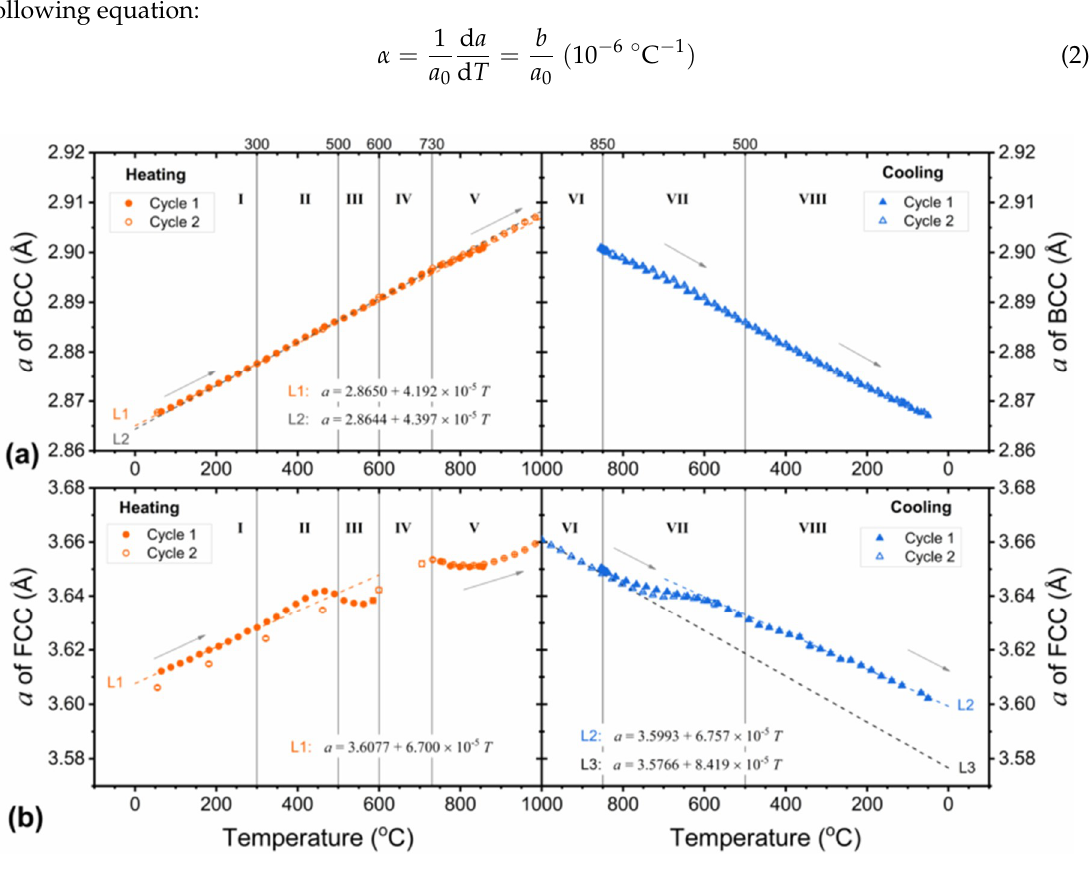
Figure 5. Evolution of lattice parameter as a function of temperature: ( a ) BCC and ( b ) FCC. The dash lines are the linear fittings by Equation (1) in different temperature regions: ( a ) L1 for 60~300 °C, L2 for 600~700 °C, and L3 for 900~1000 °C; ( b ) L1 for 60~300 °C, L2 for 300~60 °C, and L3 for 1000~900 °C. The reference temperature was set to 0 °C for comparison convenience.